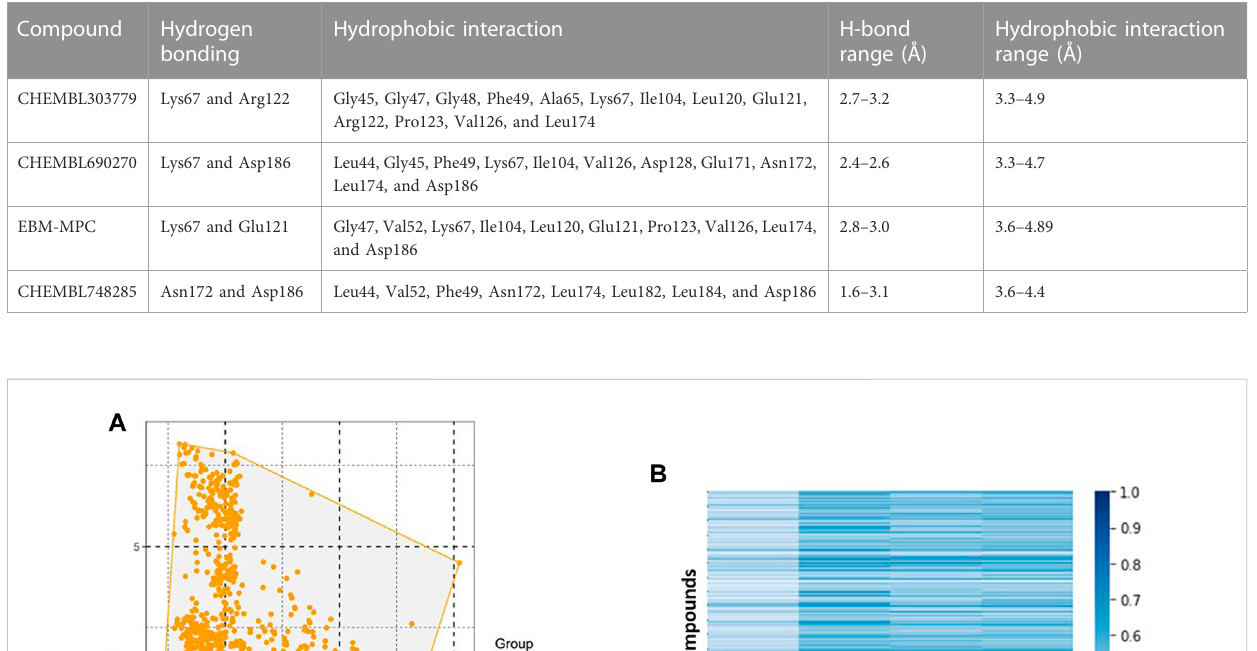
TABLE 3 Binding mode analysis of the four selected inhibitors.